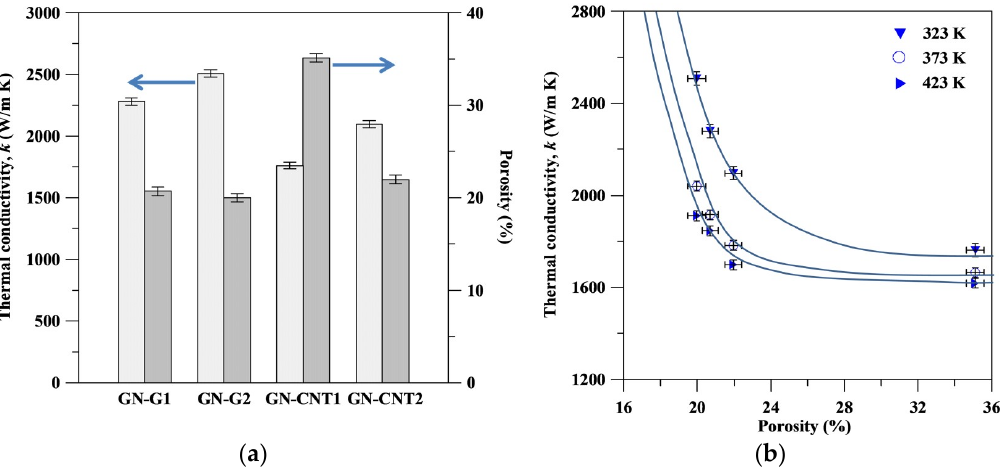
Figure 5. ( a ) The relationship between the porosity and the k value and ( b ) the k value as a decreasing function of the porosity of GN ‐ based heat sinks. This result reveals that the porosity of heat sink is strongly correlated to the volumetric C p value, playing an important role in affecting thermal diffusivity.